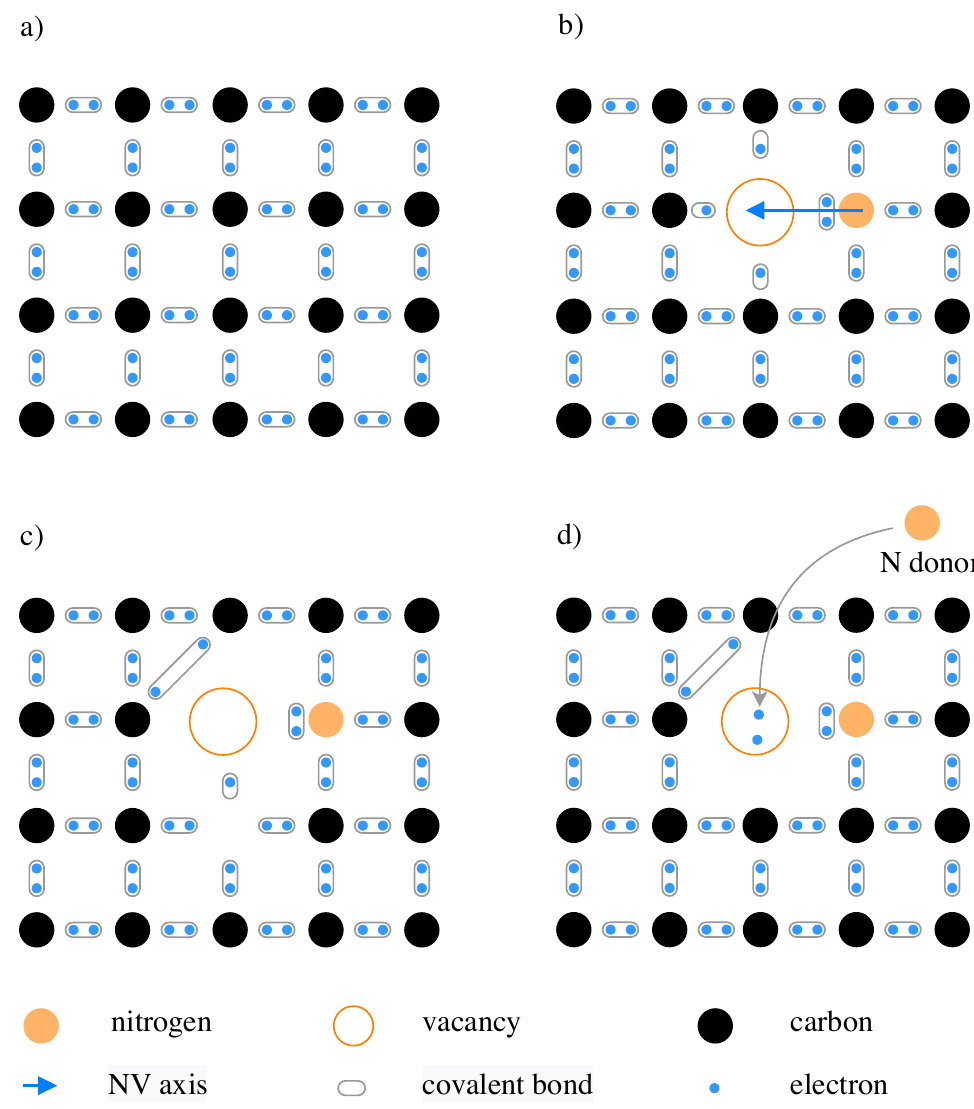
Figure 1. Simplified, flat representation of the diamond lattice. ( a ) A missing carbon atom, or vacancy, and the nearest neighbor, a substitutional nitrogen atom, create the NV center where the axis aligns the nitrogen atom with the vacancy, in one of four possible orientations. ( b ) The nitrogen atom has five electrons in the valence band, three of them form three covalent bonds with the three neighbor carbon atoms, leaving a lone pair. From the carbon atoms surrounding the vacancy, three electrons from dangling bonds are also part of the center, one remains unpaired, and the other two form a covalent bond ( c ). A total of five electrons leads to the neutral NV 0 state which does not exhibit the magnetic activity as the negative charge state NV − does. When the center captures a sixth electron [22], normally from another nitrogen atom donor in the lattice ( d ), the center is charged negatively and shows the expected behavior useful in